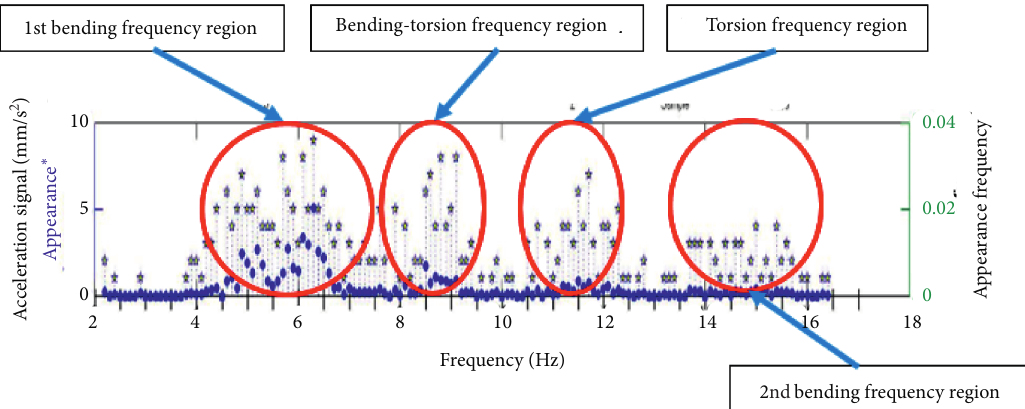
Figure 21: The representative power spectral density of Linh Xuan flyover bridge. Table 17: Characteristics of natural frequencies of the 4th span of Thu Duc 2 flyover bridge through 3 different measurement periods. Natural Spans